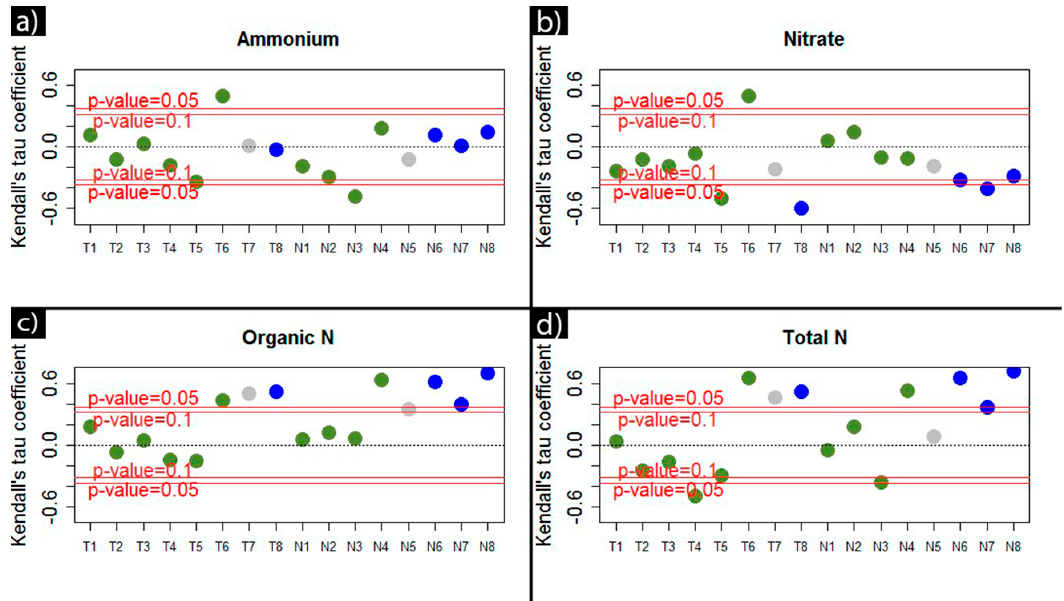
Figure 5. Kendall’s tau coefficient for a ) ammonium, b ) nitrate, c ) organic nitrogen and d ) total nitrogen in riverine (green), estuarine (grey) and coastal (blue) sites. Significant trend at a 90% and 95% confidence level are located above (increasing trend) or below (decreasing trend) the red lines.